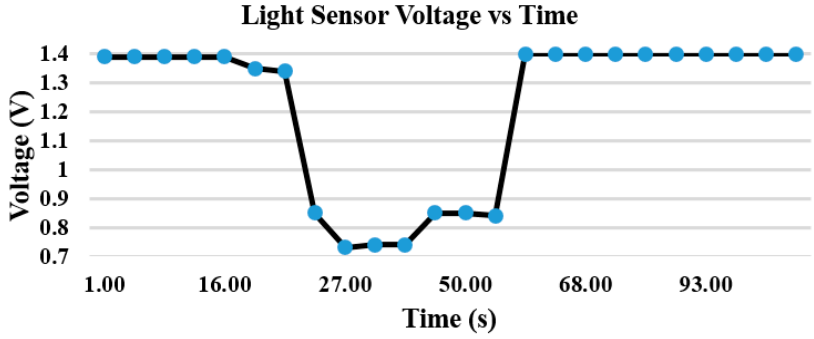
Figure 6. The recorded light sensor voltage level resultant from this fire hazard event.